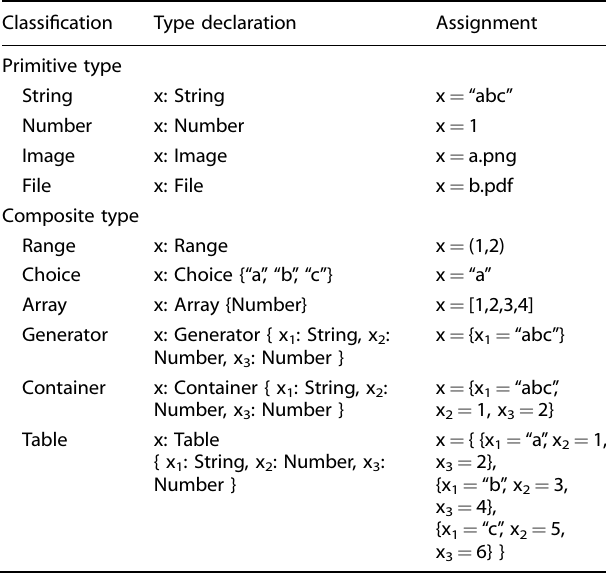
x: Table { x 1 : String, x 2 : Number, x 3 : Number